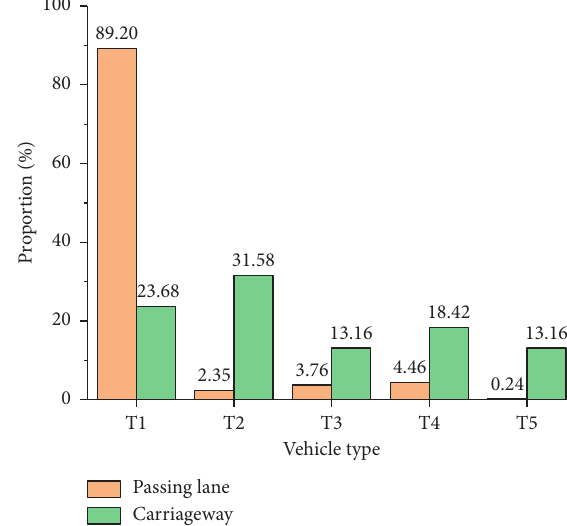
Figure 13: The vehicle type of selected